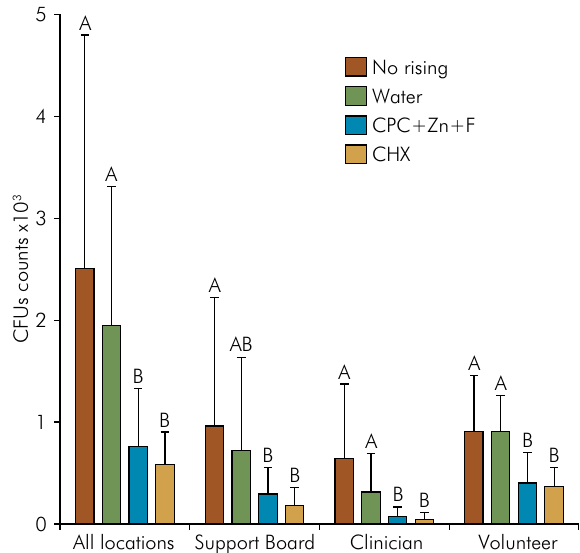
VolunteerClinicianSupport BoardAll